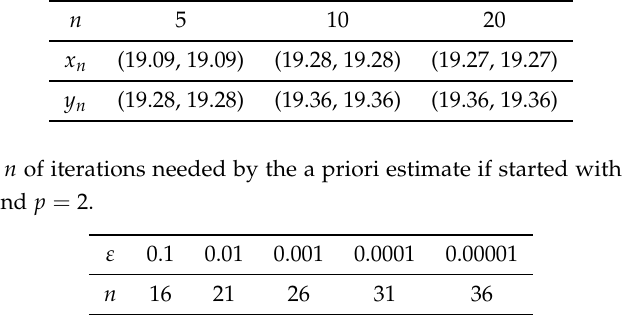
Table 15. Values of the iterated sequence ( x n , y n ) if started with x = ( 10,10 ) , y = ( 50,50 ) .